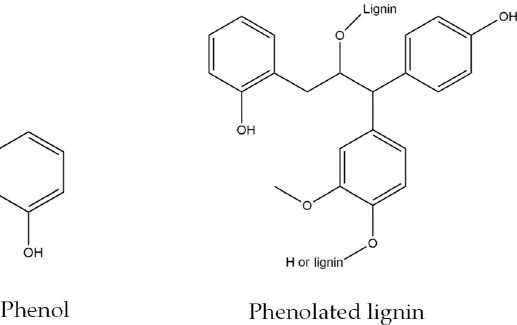
Figure 1. The chemical structure of phenol and phenolated lignin. (Figures redrawn from [17]).